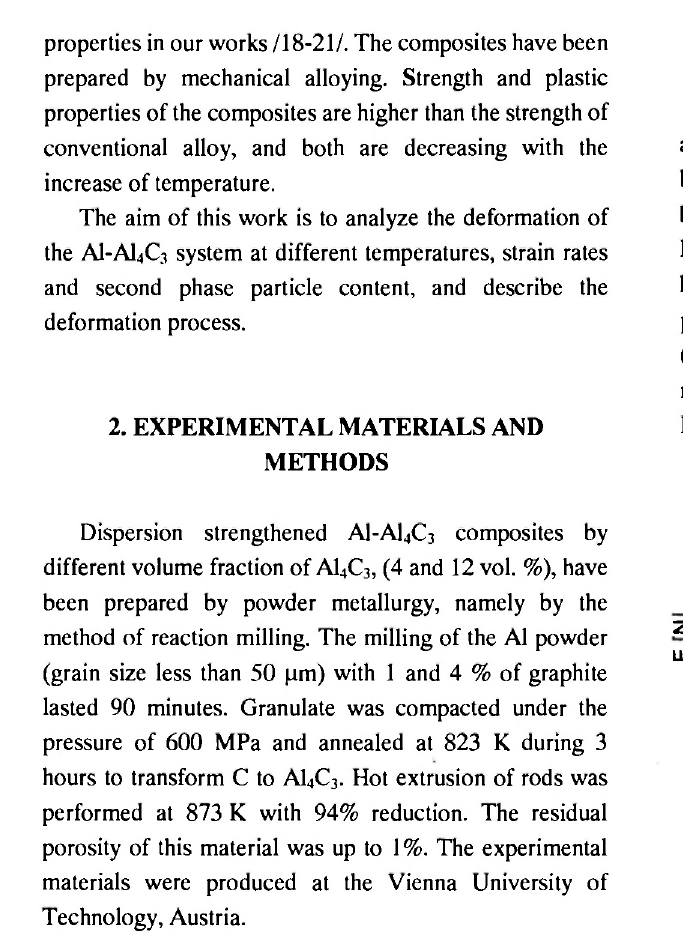
Fig. 2: F-ΔΙ curves comparison for A1-12AI 4 C, material by temperatures 273 and 723 K, strain rate 10''s"